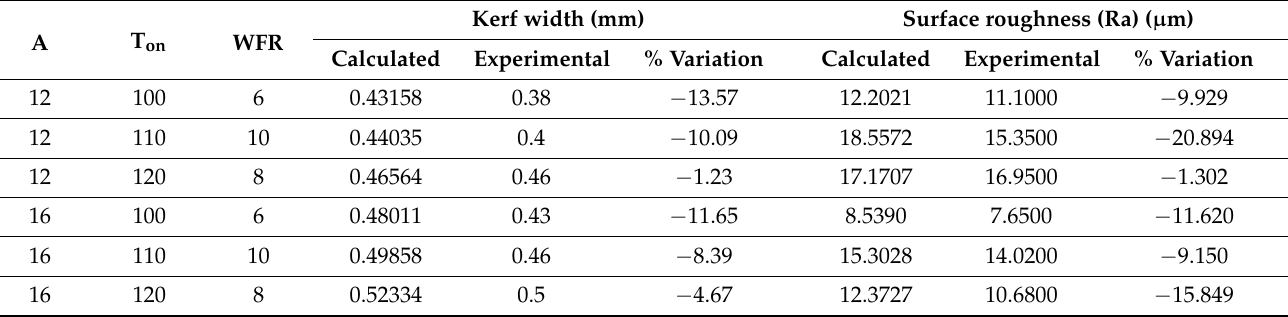
Table 15. Validation table for Al6351–5% SiC–1% B 4